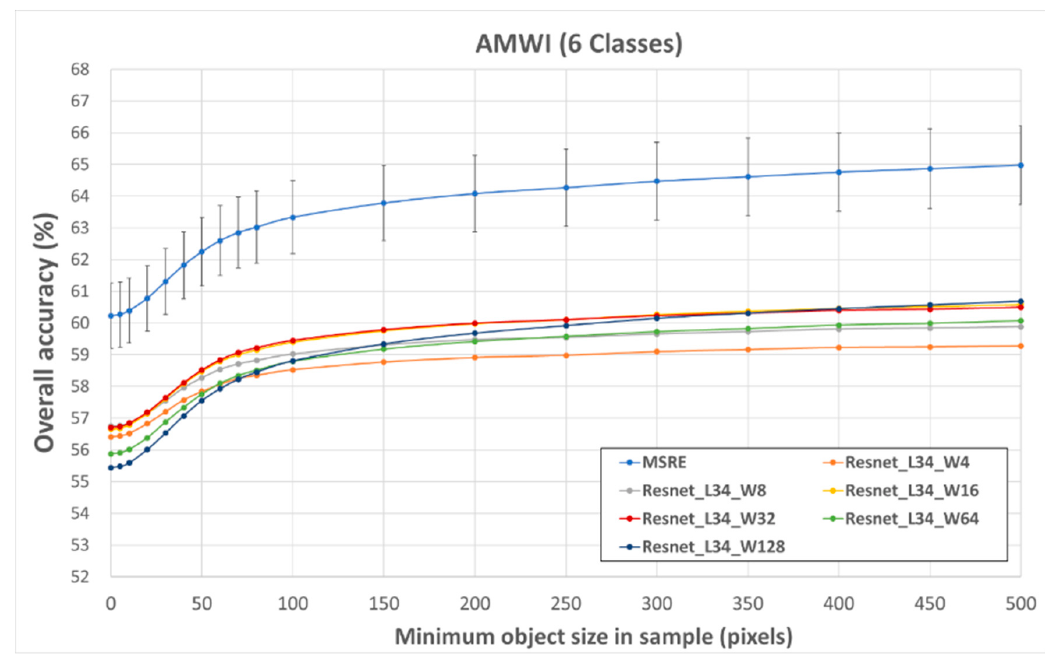
Figure 6. Overall accuracy for AMWI with minimum object size in the test sample for the six CWCS classes based on the spatial extension assessment and best-test training convergence. Remote Sens. 2019 , 11 , x FOR PEER REVIEW